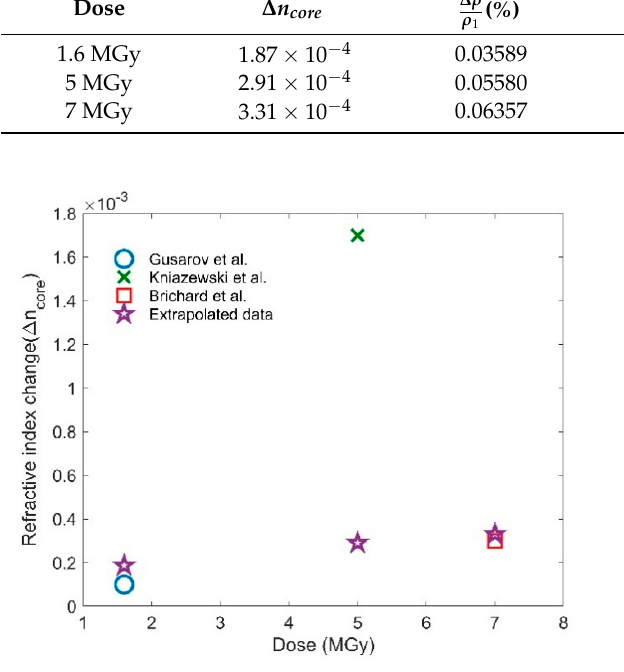
Figure 11. Calculated RI with the experimental values at MGy dose.